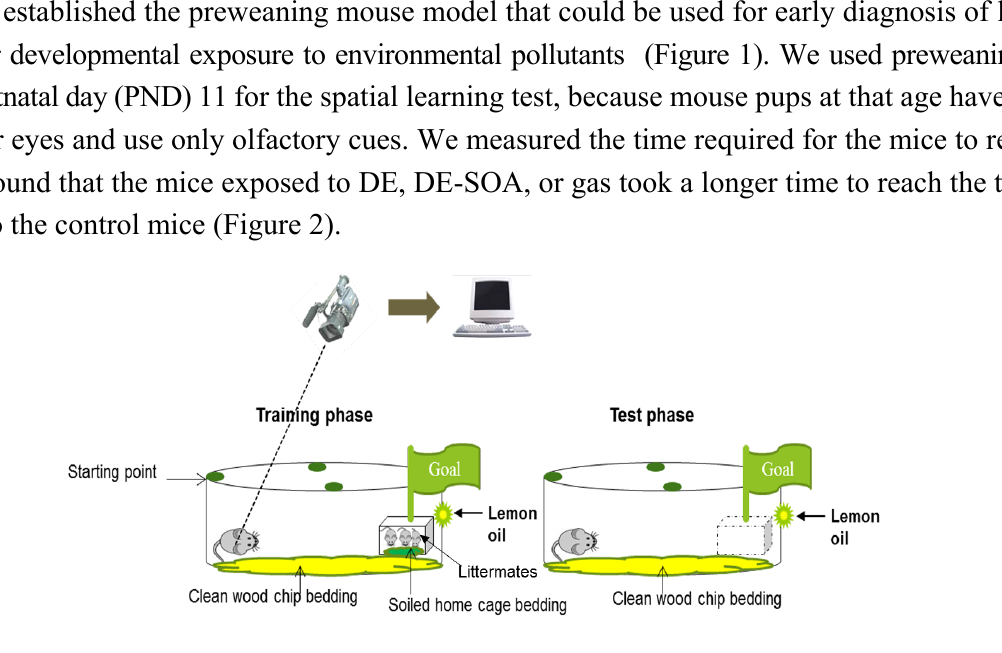
Figure 1. Establishment of the olfactory-based spatial learning test for preweaning mice.